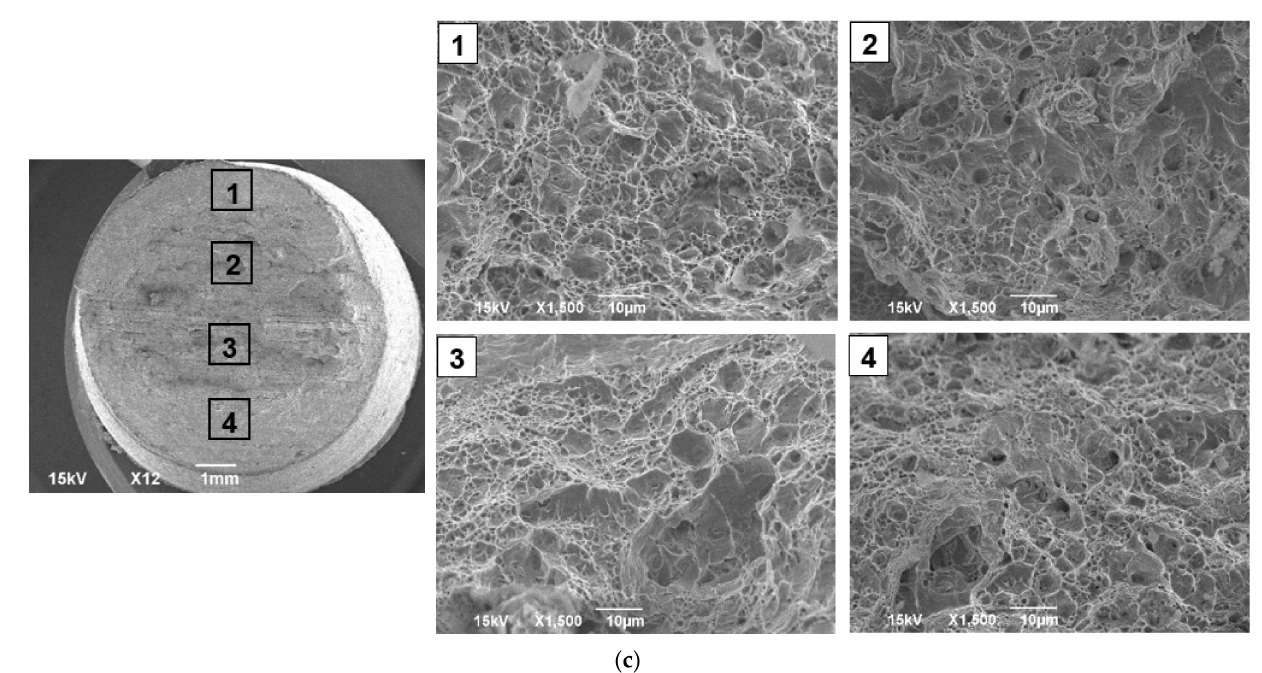
Figure 7. Scanning Electron Microscope (SEM) fractographs (JEOL, Tokyo, Japan) of ASTM A572 Gr. 50 steel, ( a ) SPR RT specimen, ( b ) SPR-1000-AC, and ( c )